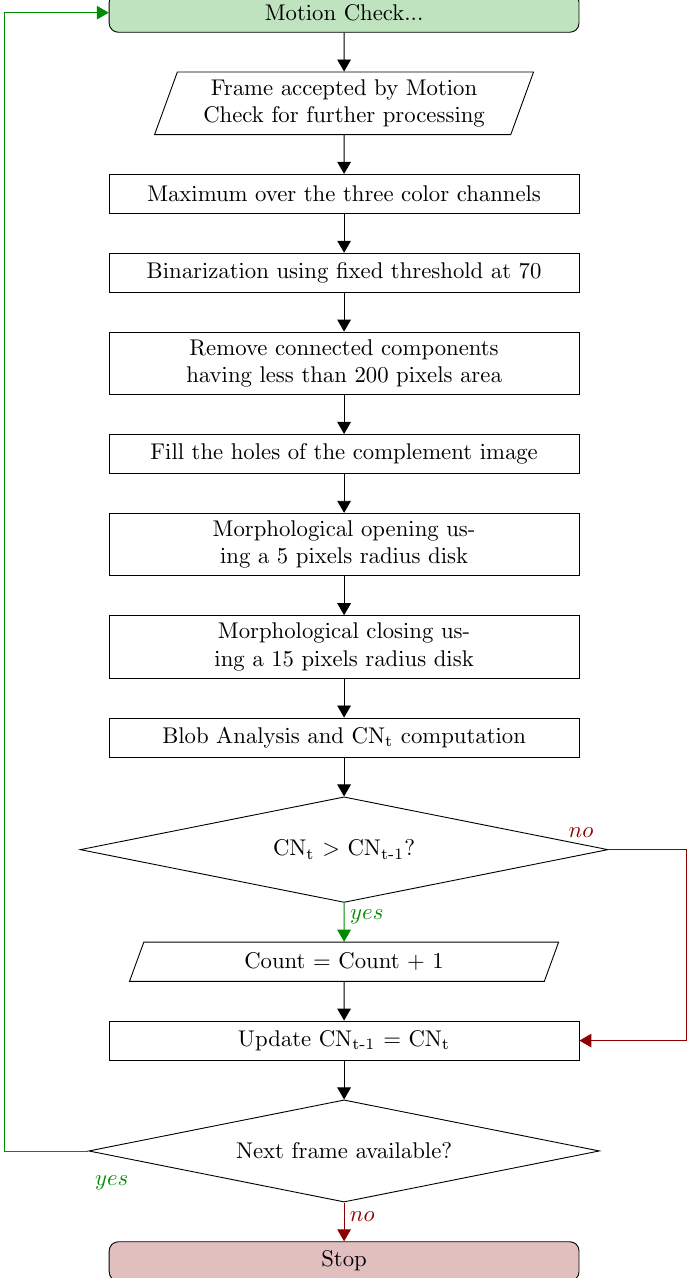
Figure 6. Detailed flowchart of the Blob-based